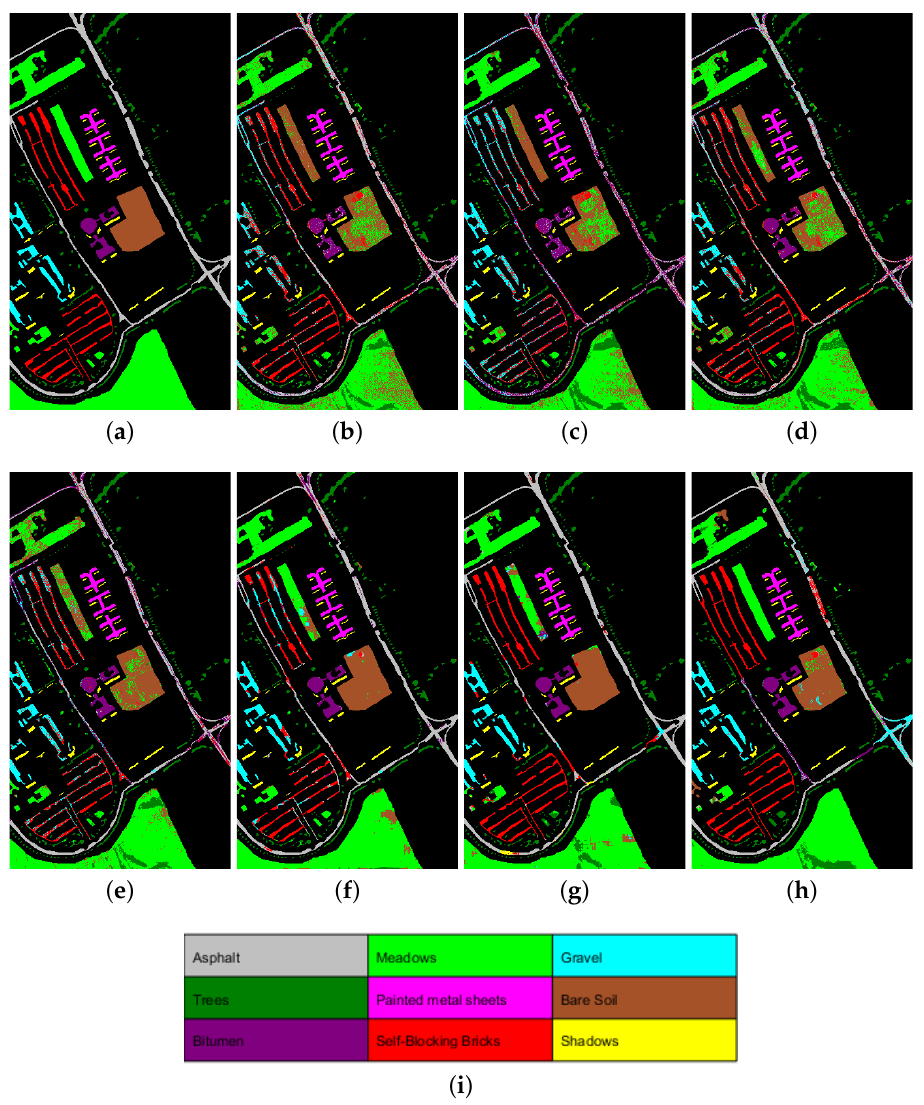
Figure 5. Classification maps of different models on the University of Pavia dataset: ( a ) ground truth; ( b ) SVM: OA = 70.66%; ( c ) ELM: OA = 65.37%; ( d ) KELM: OA = 74.43%; ( e ) PCA-KELM: OA = 79.11%; ( f ) CK-KELM: OA = 91.28%; ( g ) LBP-KELM: OA = 90.31%; ( h ) SP-KELM: OA = 91.87%; and ( i ) color bars for land